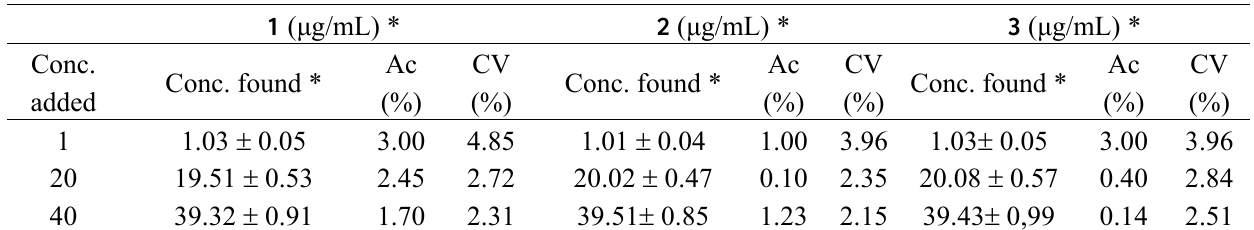
Table 3. Inter-day accuracy and precision of the HPLC method for the determination of the flavonoids ( 1 - 3 ) in samples A - E (n = 5 for each sample). 1 ( μ g/mL) * 2 ( μ g/mL) * 3 ( μ g/mL)